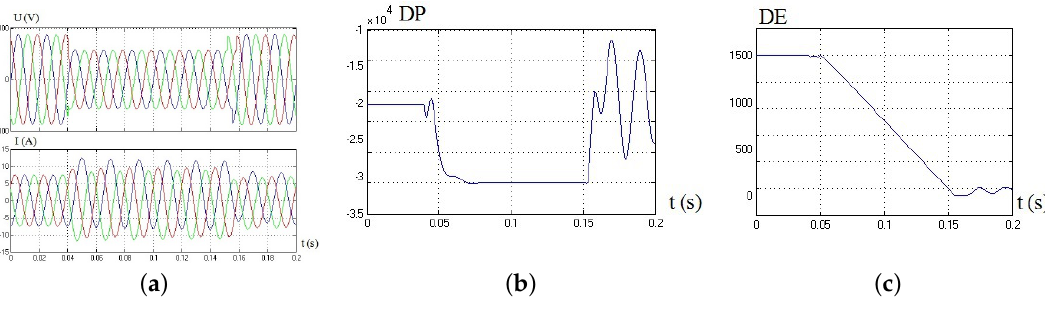
Figure 11. Disturbance signals for Case 2: ( a ) voltage and current at F ; ( b ) DP signal; ( c ) DE